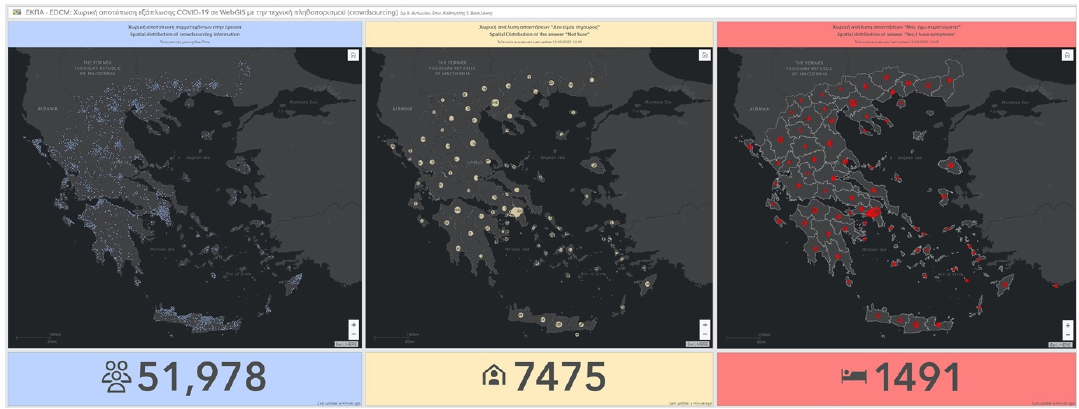
Figure 2. Dashboard showing the survey responders location, in real time (map on the left) and aggregation analysis for “Not Sure” (map in the middle) and “Yes” (map on the right) per Regional Unit performed every 3 hours (https://arcg.is/00Kanf). Indicators below the maps show the total number of responders, Not Sure and Yes, respectively. Screenshot was taken on 18/03/2020 12:00 (EET).